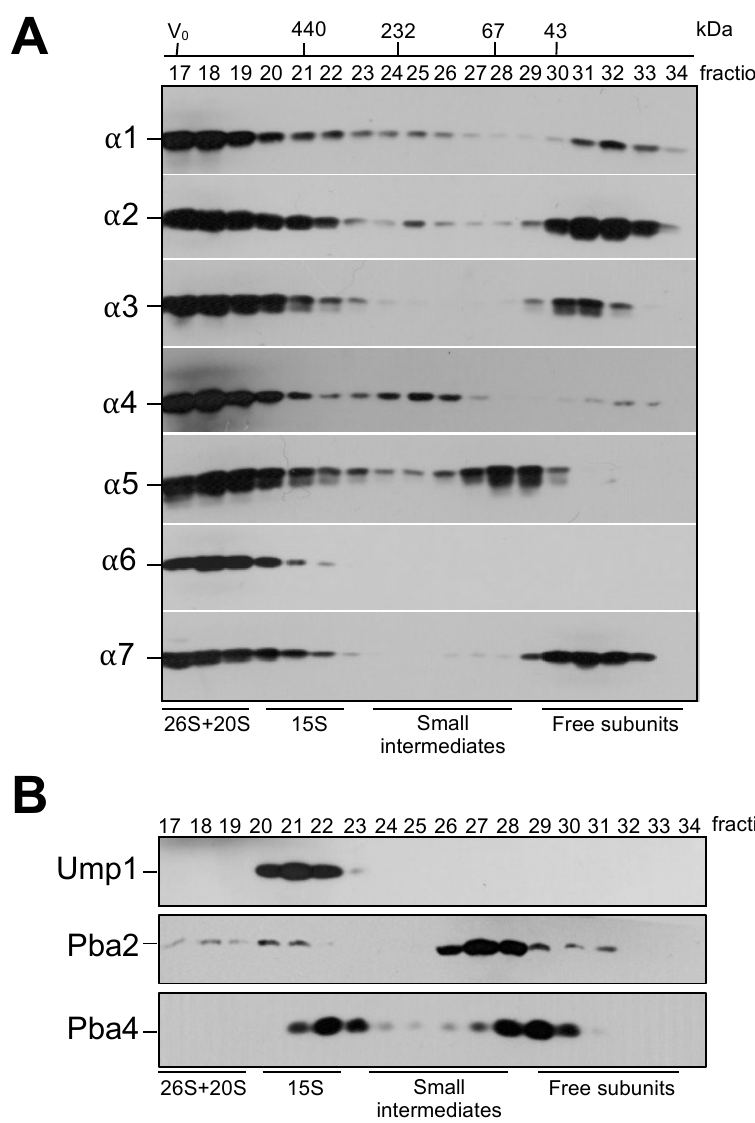
Figure 1. Separation of proteasomal complexes and intermediates according to their molecular weight. To define the distribution by size of the indicated tagged polypeptides in proteasome intermediates and complexes, crude extracts from strains expressing 2xHA tagged versions of the indicated α subunits ( A ) or proteasome-dedicated chaperones ( B ) were separated in a Superdex200 gel filtration column. Fractions were subjected to SDS-PAGE and anti-HA Western blotting. The numbers of fractions (17 to 34) used in the analysis, and the positions of molecular weight standards (kDa) used to calibrate the column are indicated at the top of the panel. Peak positions of 26S and 20S proteasomes, 15S PCs, small intermediates and free subunits are indicated at the bottom.